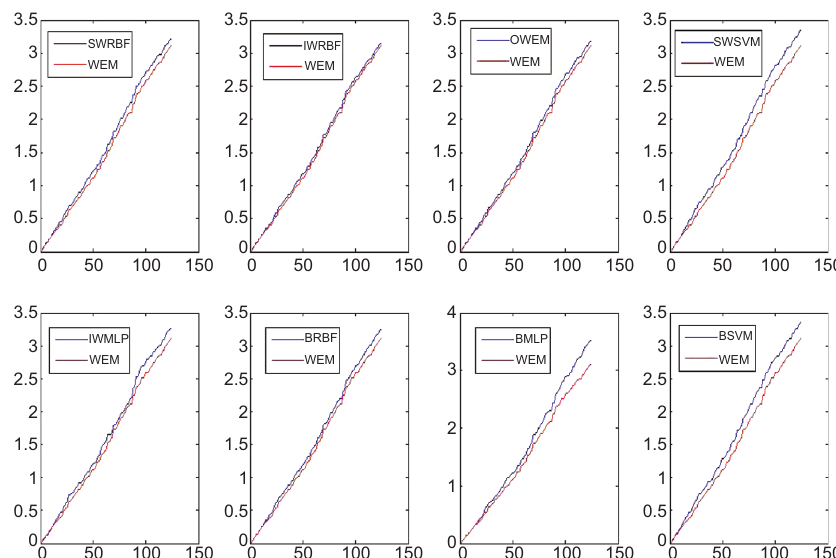
Figure 4. Cumulative Absolute Errors Map.